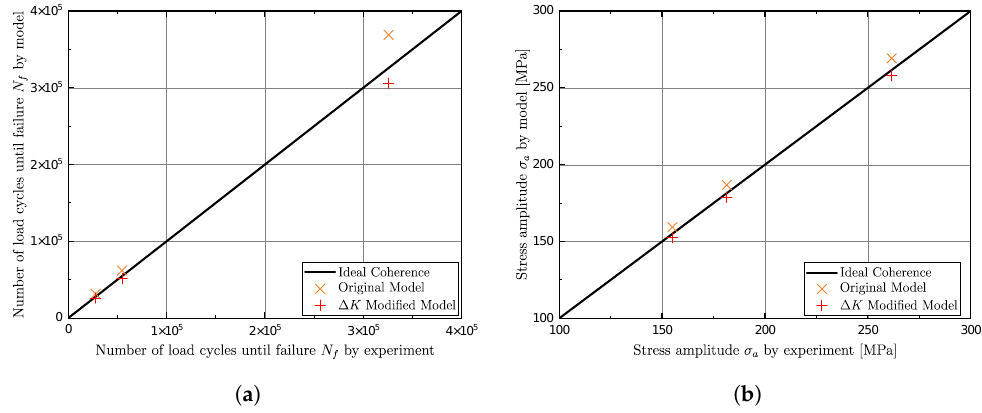
Figure 12. Comparison of results by experimental and model. ( a ) For constant load stress amplitude σ a . ( b ) For constant number of load cycles N f